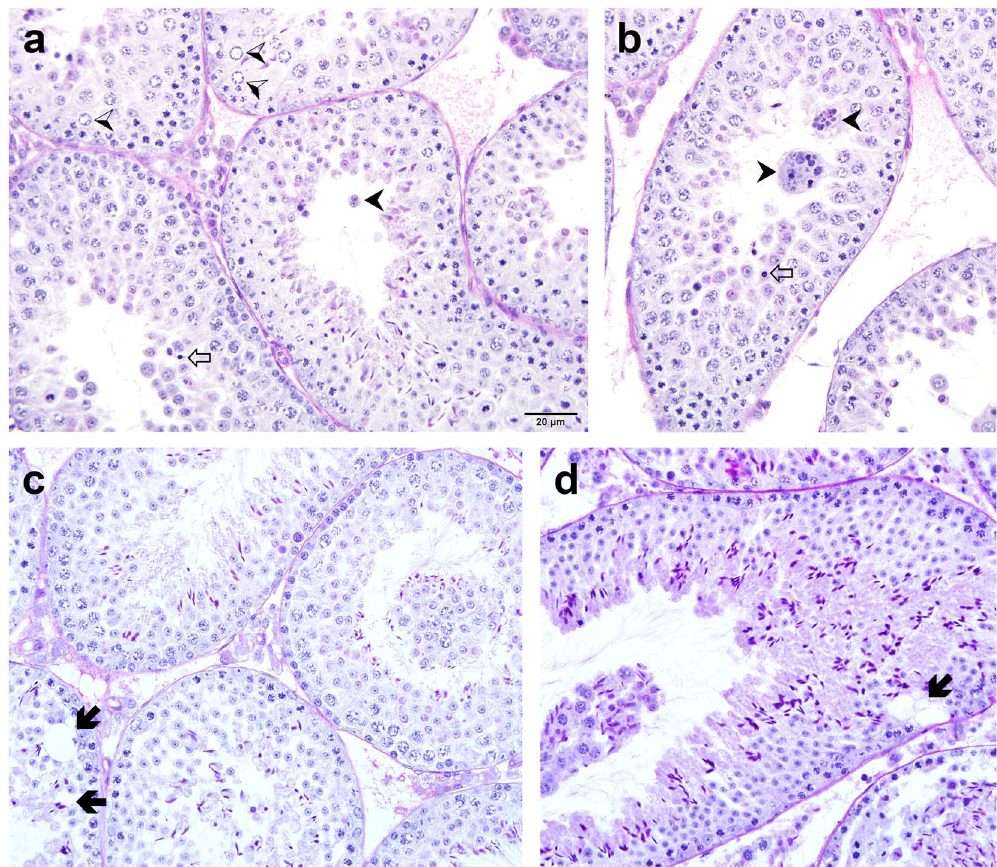
Figure 3. Histology of the testes of Plag1 knock-out mice. ( a , b ) Testis of a 3-week-old male, showing large symplasts (black arrowheads), marginated nuclear chromatin (black-and-white arrowheads) and pyknotic nuclei (open arrows). ( c , d ) Testis of a 5-week-old male, showing sloughing of spermatocytes and spermatids, and tubular vacuolation (black arrows). Sections were stained with periodic acid − Schiff and hematoxylin. Magnification as per the scale bar shown in a